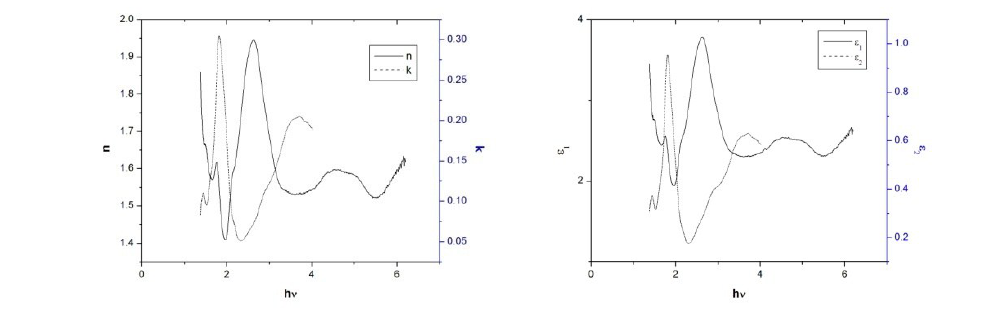
Figure 6 . Plot of real and imaginary parts of the dielectric constant versus photon FePc Thin energy for as-deposited Cl 16